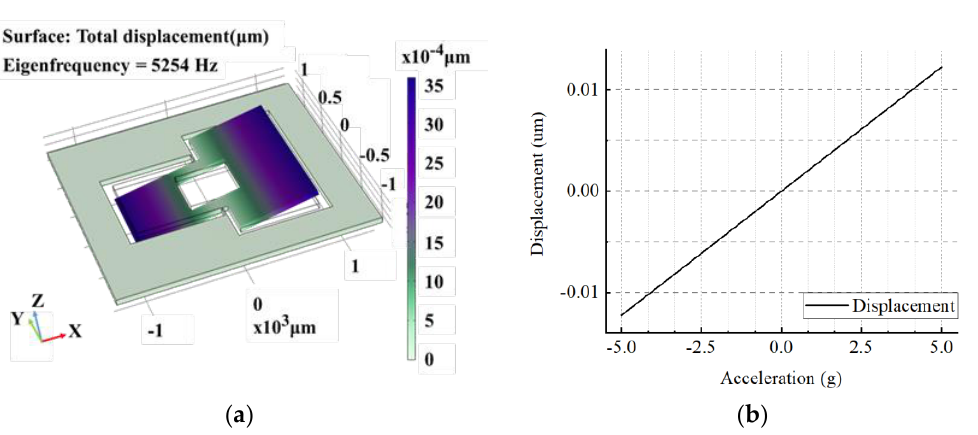
Figure 2. Simulation of the teeter-totter accelerometer. ( a ) Simulation of the accelerometer. ( b ) Displacement of the mass.